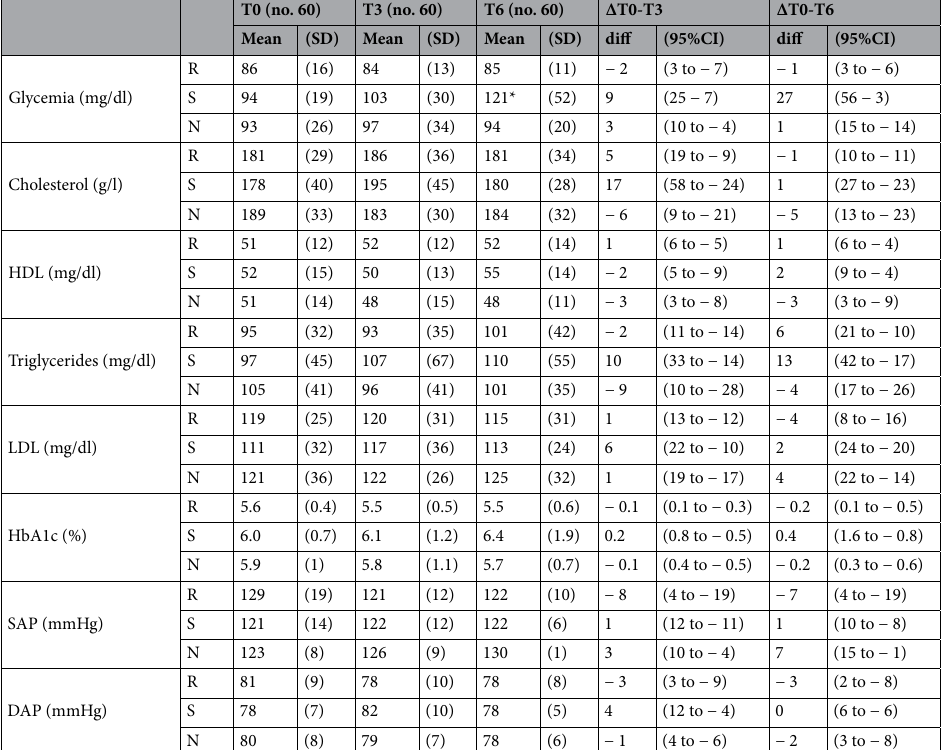
Table 3. Biochemical parameters and arterial pressure of Prader–Willi syndrome (PWS) patients at baseline, after 3 and 6 years follow-up. Measurements are reported as mean and standard deviation (SD), while changes are reported as mean difference and 95% confidence interval (CI). *: significantly different from the responsive subgroup ( p < 0.05); N: non-responsive patients; HDL: high density lipoprotein; LDL: low density lipoprotein; HbA1c: glycated haemoglobin; SAP: systolic arterial pressure; DAP: diastolic arterial